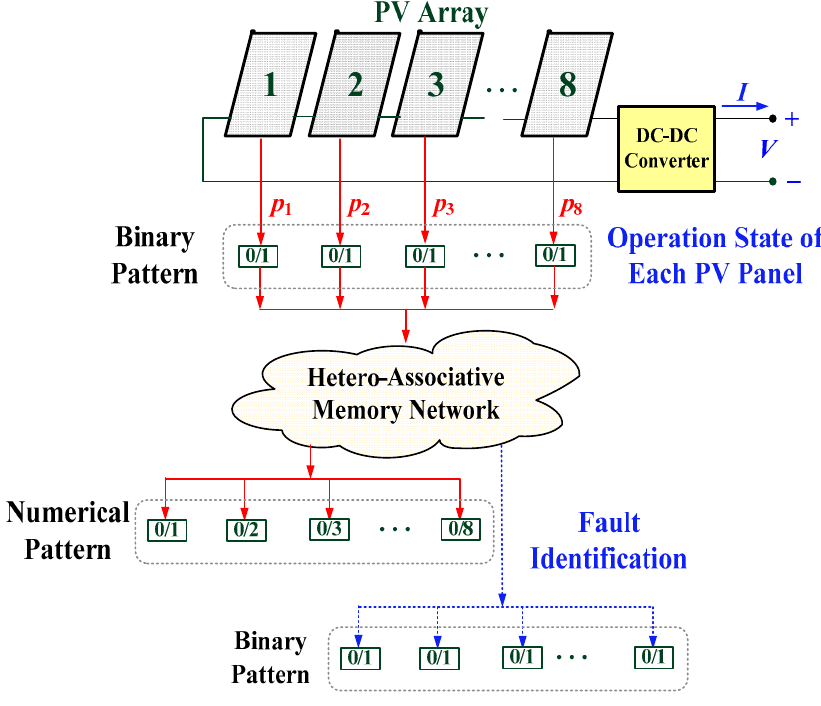
Figure 1. Schematic diagram of multiple fault location in a PV array using hetero-associative memory network.